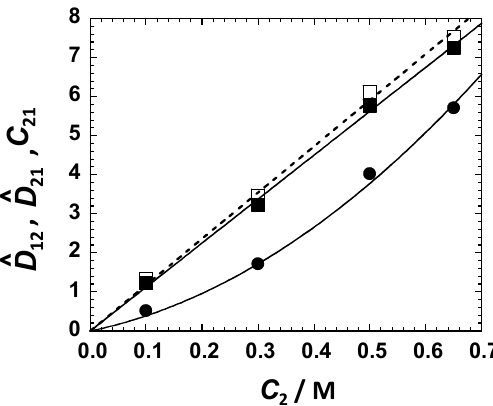
Figure 3. Micelle diffusiophoresis coefficient, ˆ D 12 ( • ), describing micelle diffusion induced by the salt concentration gradient; salt osmotic diffusion coefficient, ˆ D 21 ( (cid:4) ), describing salt diffusion induced by the micelle concentration gradient; and preferential-interaction coefficient, C 21 ( (cid:3) ), describing salt equilibrium distribution along a micelle concentration gradient as a function of MgSO 4 concentration, C 2 . Curves associated with ˆ D 12 (solid curve), ˆ D 21 (solid line), and C 21 (dashed line) are fits through the data.